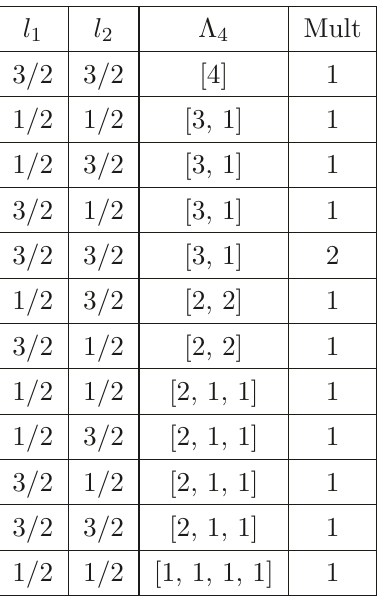
Table 9 . Results for n = 4 fields and k = 3 derivatives.